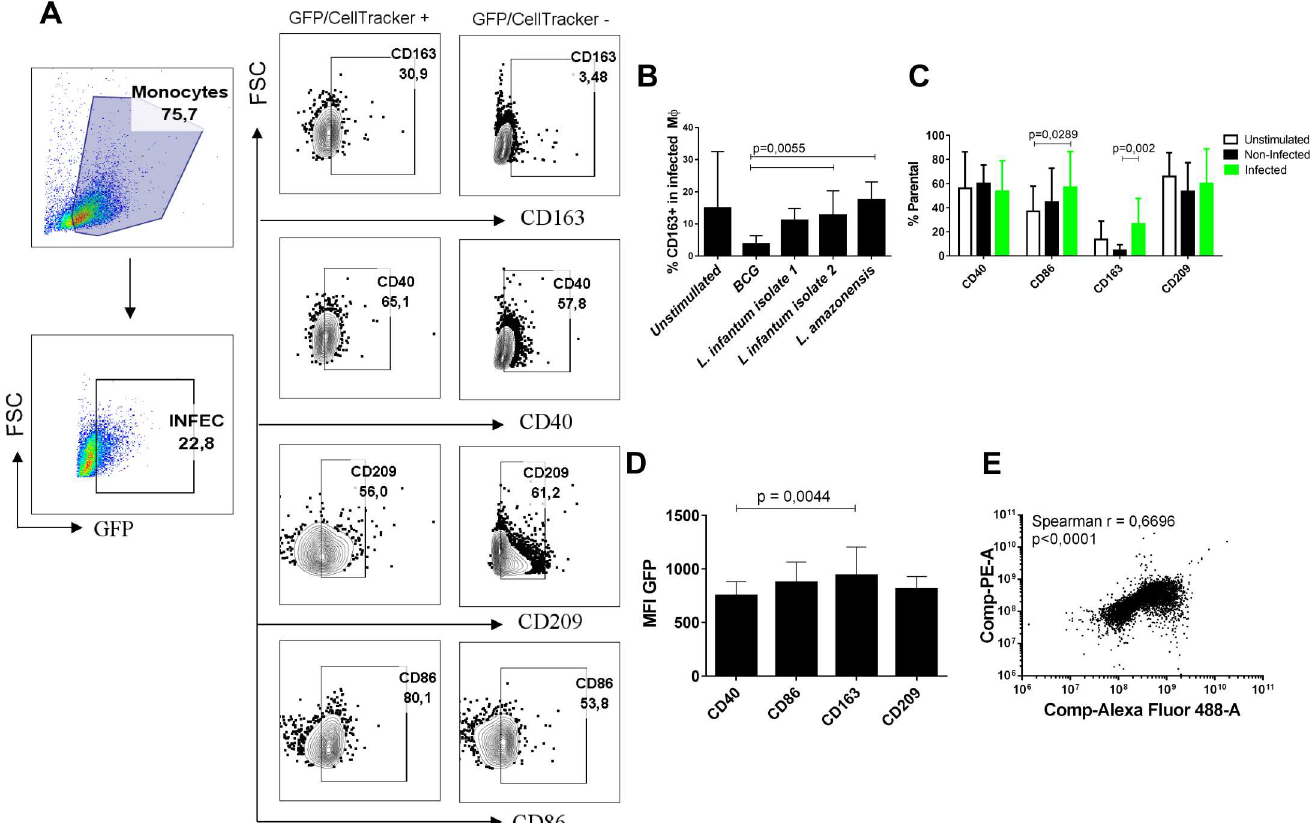
Fig 3. CD163 expression is induced by Leishmania infection of monocyte/macrophages. (A) Gating strategy for analysisof monocyte/ macrophage phenotypes. PBMC were collectedfrom healthydonors and the adherent cells culturedfor 5 days in RPMI 1640plus 20% FBS. The cells were infected with L . amazonensis- GFP (10 parasites: 1 macrophage), two isolates of L . infantum CellTracker stained (5:1) or BCG CellTrackerstained (2:1), and incubatedwith antibodiesspecific for macrophage surface moleculesprior to analysisby flow cytometry. (B) Surface CD163 expressionwas quantified after 24h in infected, GFP+ cells (in duplicate,n = 5 experiments). (C) The macrophages were analyzedby FlowJo software (in duplicate, n = 6 experiments). Green and black bars represent, respectively,the infected, GFP+ and uninfected, GFP- cells after 24h of exposureto L . amazonensis GFP-expressing strain. White bars are the non-exposed group (unstimulated). The mean ± SD parentalpercentage of the cell populations (B and C) were comparedby Friedmanpaired test with Dunn’spost test. (C) MFI analysisof GFP in the different populationsaccordingto the surface phenotype, 24h after infection (n = 7 experiments in duplicate).The mean ± SD MFI of each populationwas comparedby Friedmanpairedtest with Dunn’spost test. (D) Spearman correlationanalysisbetweenCD163-PEand Leishmania- GFP fluorescence for each cell of the analysis(one representative of 7 experiments in